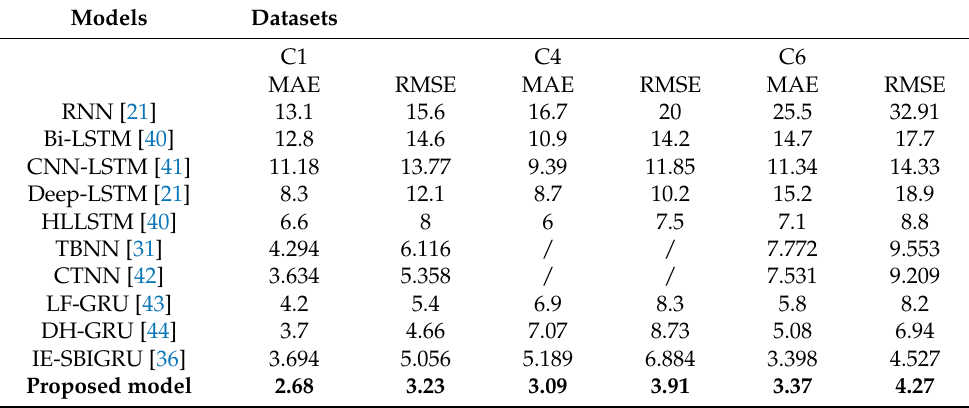
Table 4. Performance comparisons with other models.